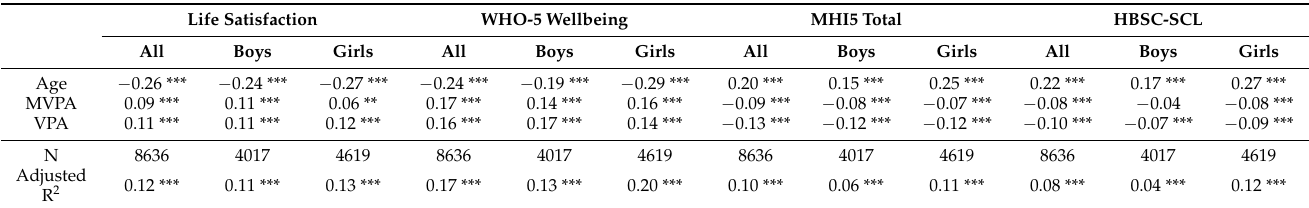
Table 4. Models of ordinary least squares (OLS) regression predicting mental health by age and physical activity by gender. Life Satisfaction WHO-5 Wellbeing MHI5 Total HBSC-SCL